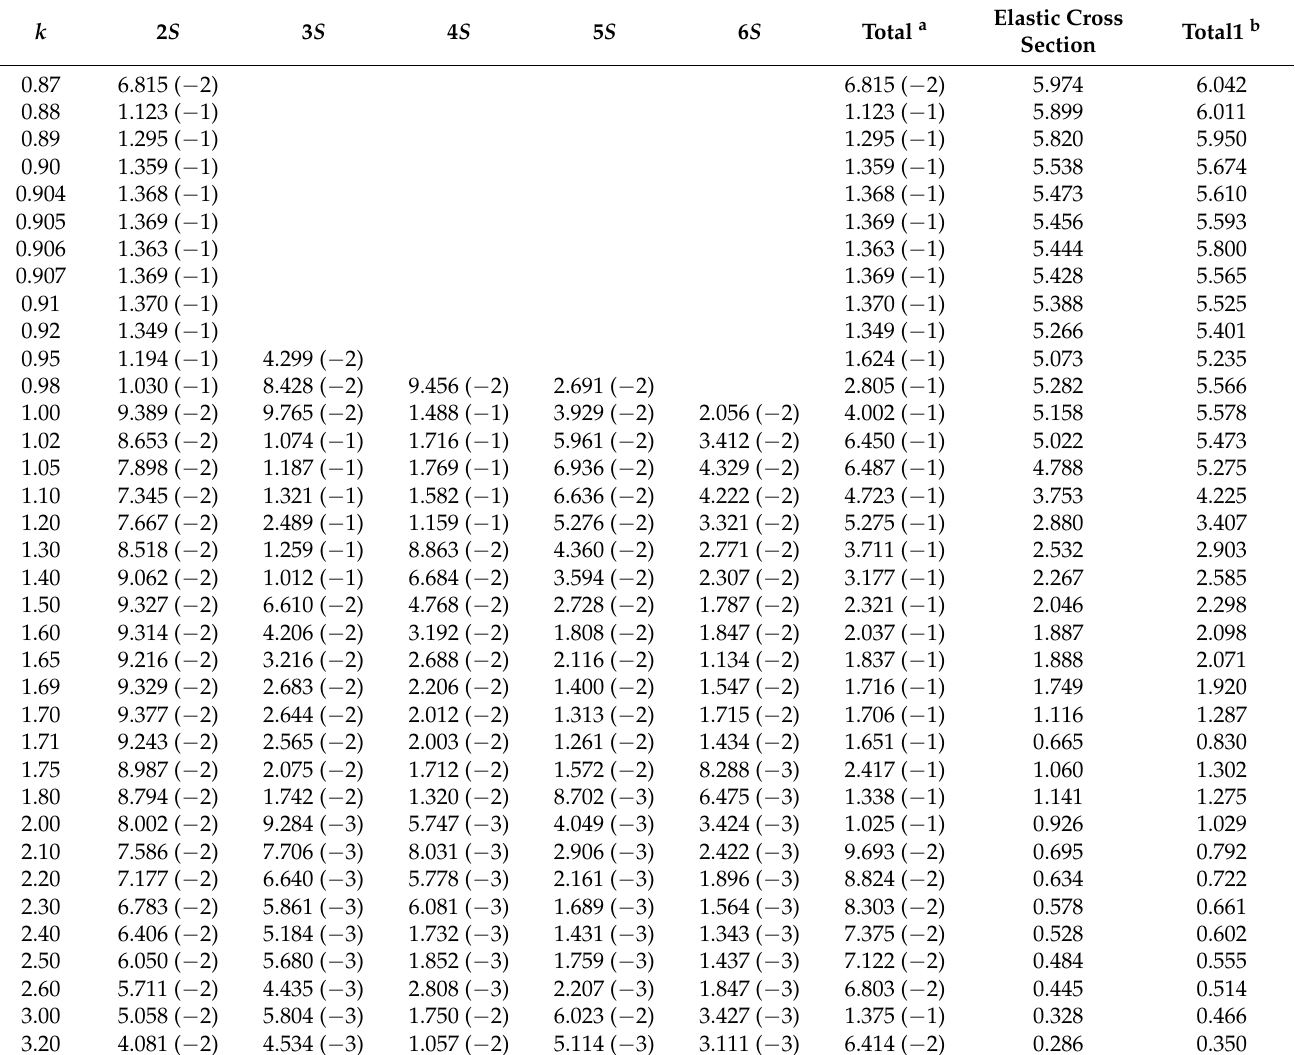
Table 1. Cross sections ( π a 2 ) of n S states of atomic hydrogen using the variational polarized orbital 0 method with maximum L max =